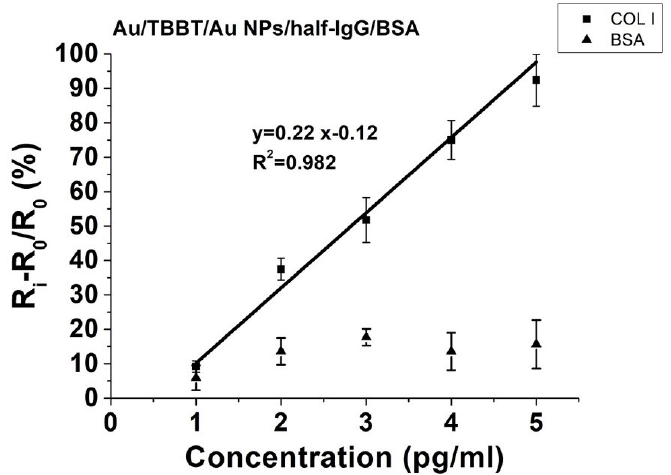
Figure 7. The correlation between (R i − R 0 )/R 0 (%) and the applied range of collagen I (COL I) concentrations (pg/mL) and the negative control of bovine serum albumin (BSA), as measured for the Au/TBBT/AuNPs/half-IgG/BSA immunosensor system. R 0 represents the value of the electron transfer resistance of a completely functionalised working electrode without any addition of the collagen I analyte (COL I), and R i is the electron transfer resistance after all steps of the electrode functionalisation, which were measured in 0.1 M PBS solution for the range of concentrations from 1–5 pg/mL ( n = 5) of collagen I (COL I).